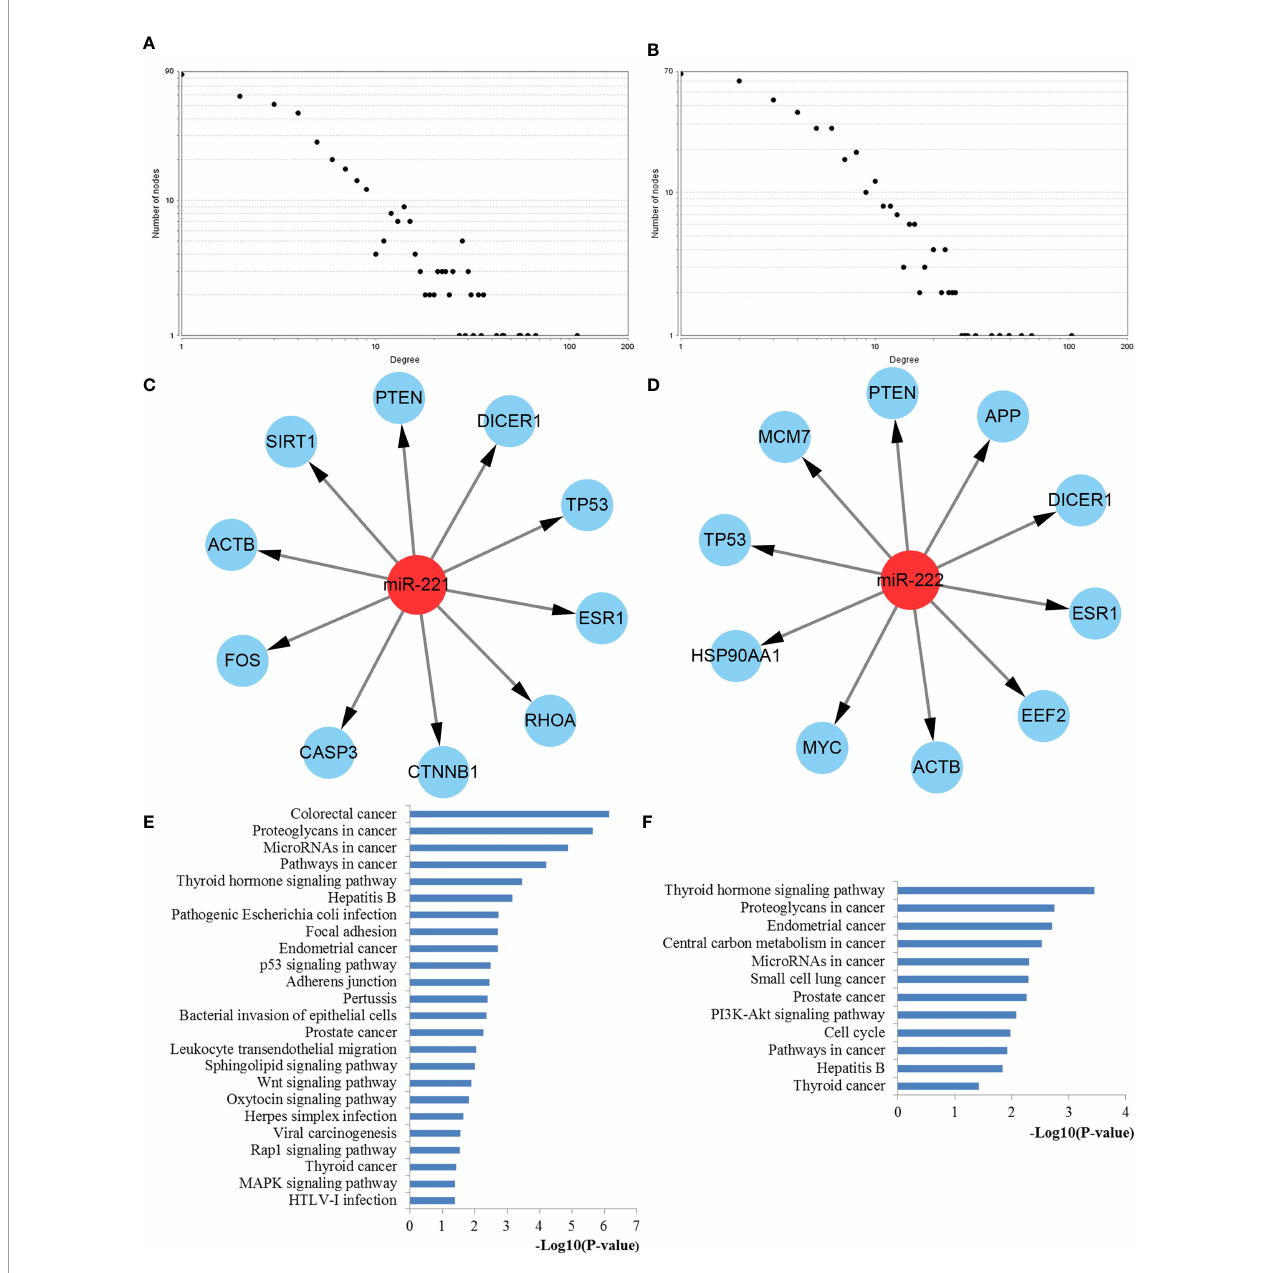
FIGURE 8 | PPI network construction results. (A) Degree distributions of nodes for network constructed with miR-221 targets; (B) Degree distributions of nodes for network set up with miR-222 targets; (C) Top ten hub genes of network for miR-221 targets; (D) Top ten hub genes of network for miR-222 targets; (E) pathway enrichment results for the identi fi ed hub genes of miR-221 targets network; (F) pathway enrichment results for the identi fi ed hub genes of miR-222 targets network. PPI protein – protein